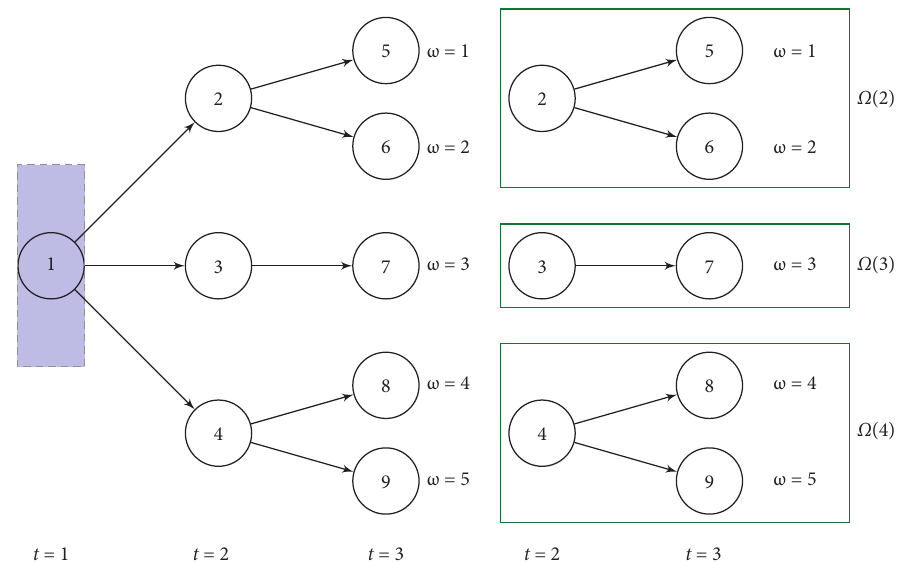
Figure 3: Structure of stochastic problem after fixing the root-node (node 1). The three subextensive forms (SEFs) denoted by Ω ( 2 ) , Ω ( 3 ) , and Ω ( 4 ) are